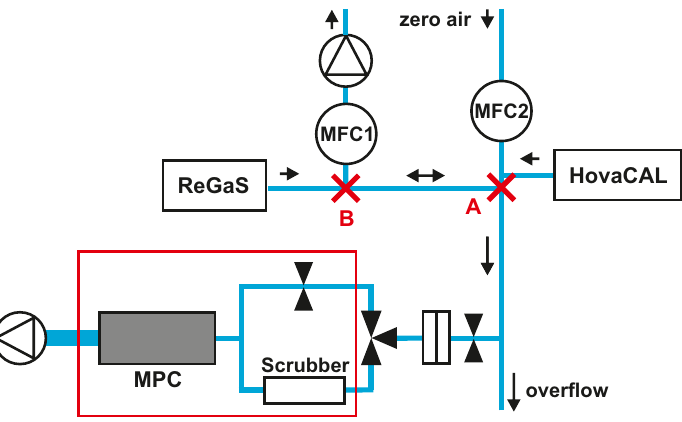
Figure 2. Laboratory setup for characterization experiments. The red frame indicates the elements embedded in the housing of the spectrometer. A: the position where the step-wise variation of HNO is applied for inlet response time experiments (see text). B: the position where the share of 3 HNO -containing air in the calibration gas mixture is controlled. Arrows indicate the flow 3